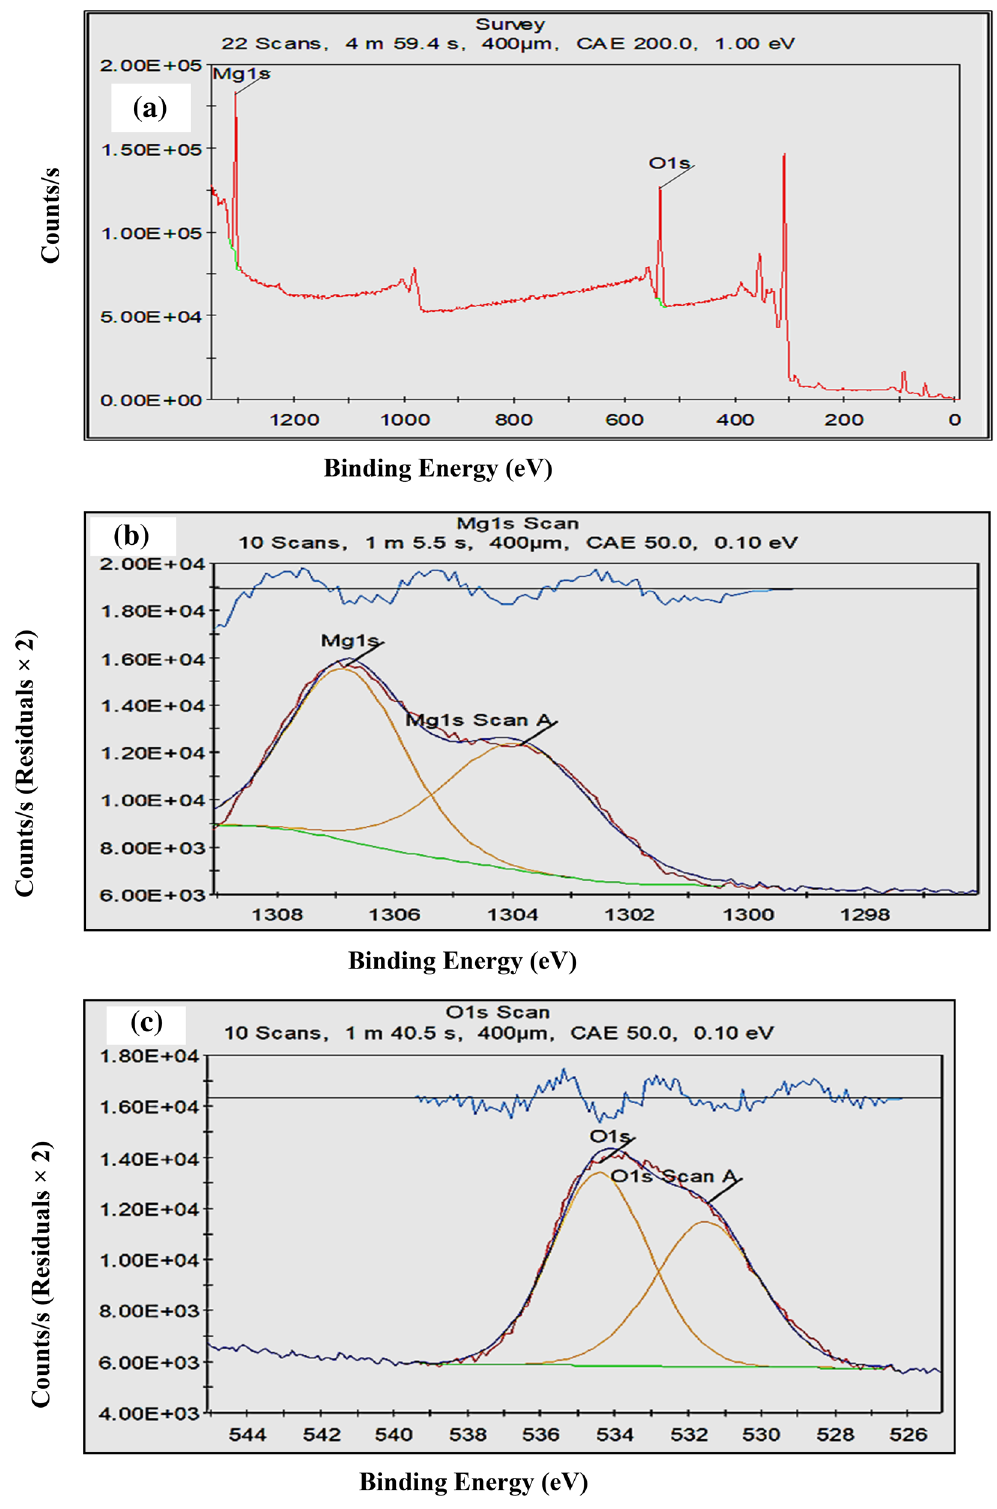
Figure 3. (a) XPS survey of RcNps as-synthesized MgO nanoparticles showing peaks for the elemental contents in the synthesized sample, (b) XPS pattern of RcNps, curve fitting of Mgs1 and (c) XPS pattern of RcNps, curve fitting of